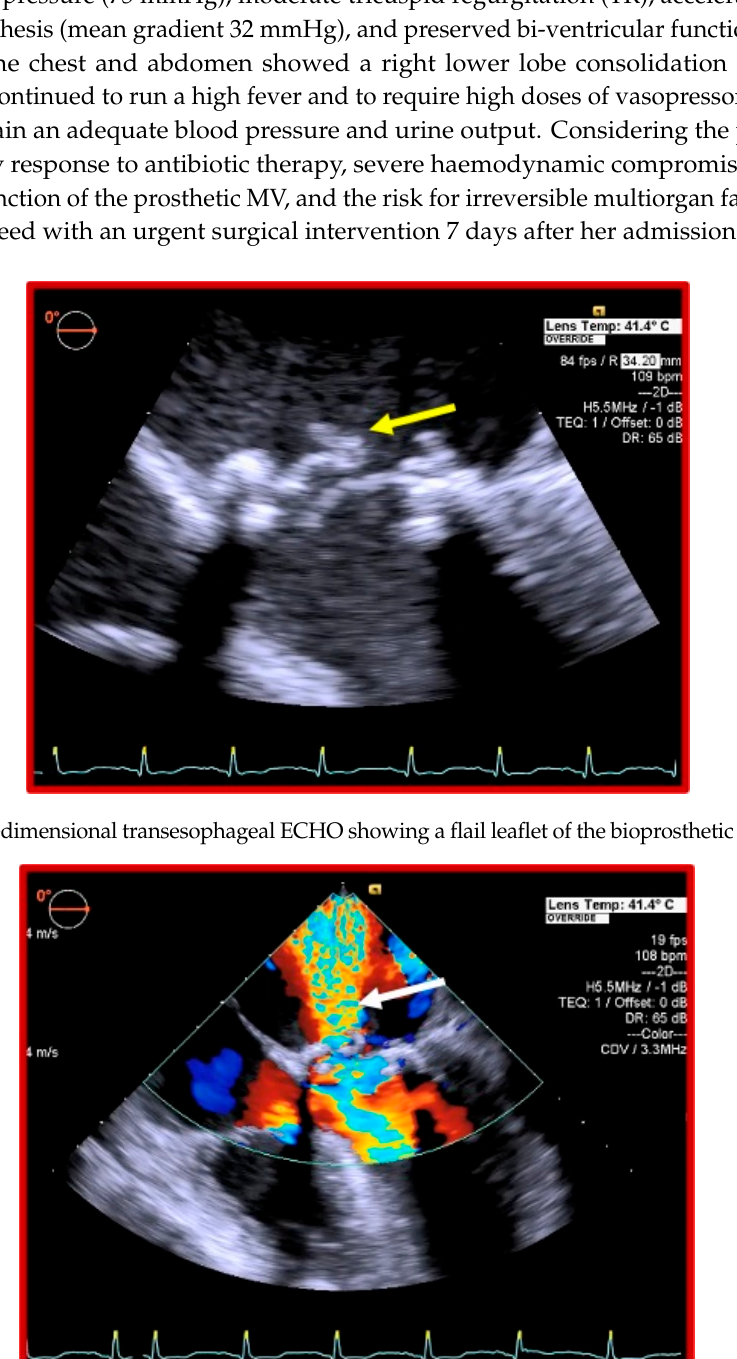
Figure 2. Doppler two-dimensional (2D) transesophageal ECHO showing a large mitral regurgitant jet.